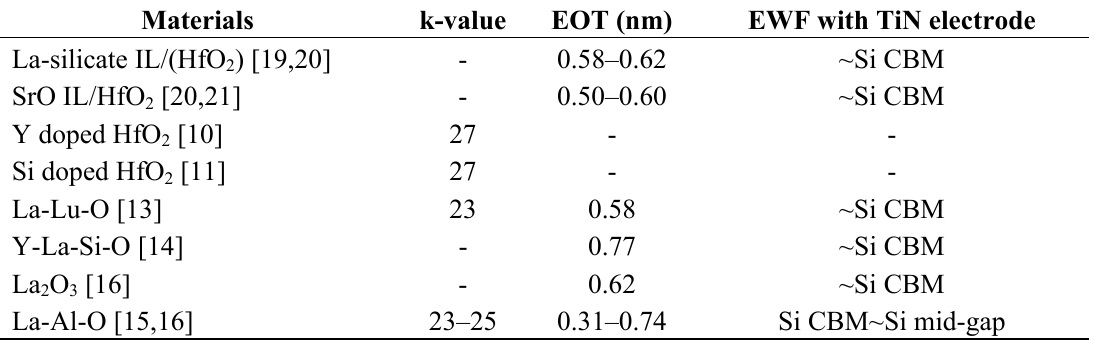
Table 1. Summary of silicon oxide based interfacial layer (IL) k-boost and higher-k data in literature. Equivalent oxide thickness (EOT), effective workfunction